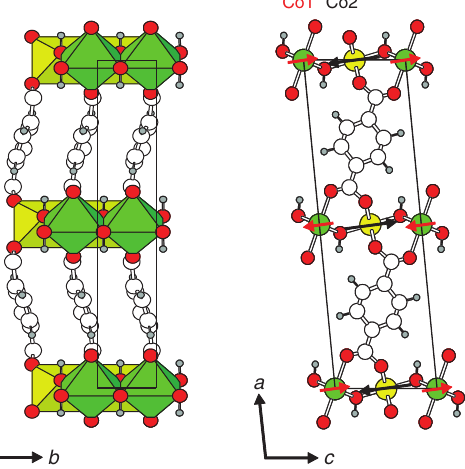
(OH) (C H O ) along c 2 2 8 4 4